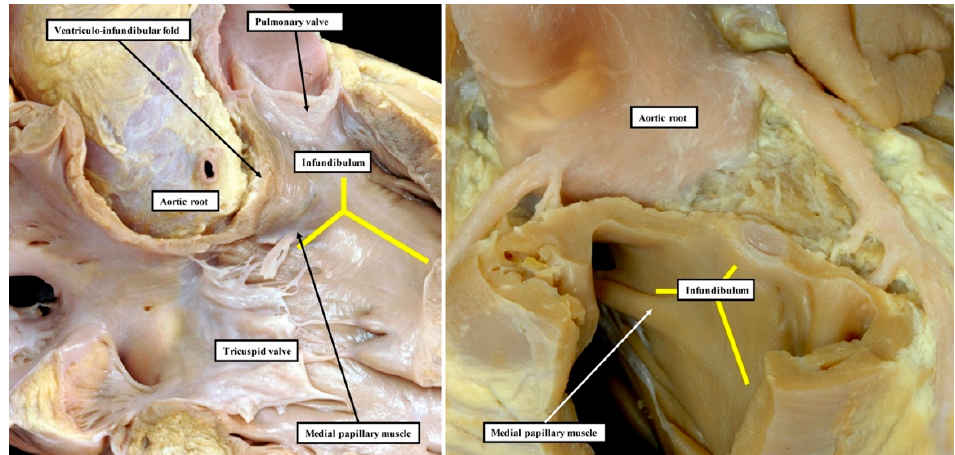
Figure 2. These images show the findings subsequent to the dissection of normal hearts. The image in the left -hand panel shows the area of extracavitary adipose tissue that interposes between the posterior wall of the infundibulum, also known as the ventriculo-infundibular fold, and the aortic root. The yellow “Y” shows the septal band, or septomarginal trabeculation, with the medial papillary muscle, or papillary muscle of the conus, arising from its postero-caudal limb. The right -hand panel shows another heart in which the myocardial sleeve supporting the leaflets of the pulmonary valve has been sectioned, permitting the pulmonary root to be lifted away from the base of the ventricular mass (see also Figure 4C). The yellow “Y” again shows the location of the septal band. The dissections reveal the lack in the normal heart of a “muscular outlet septum”.